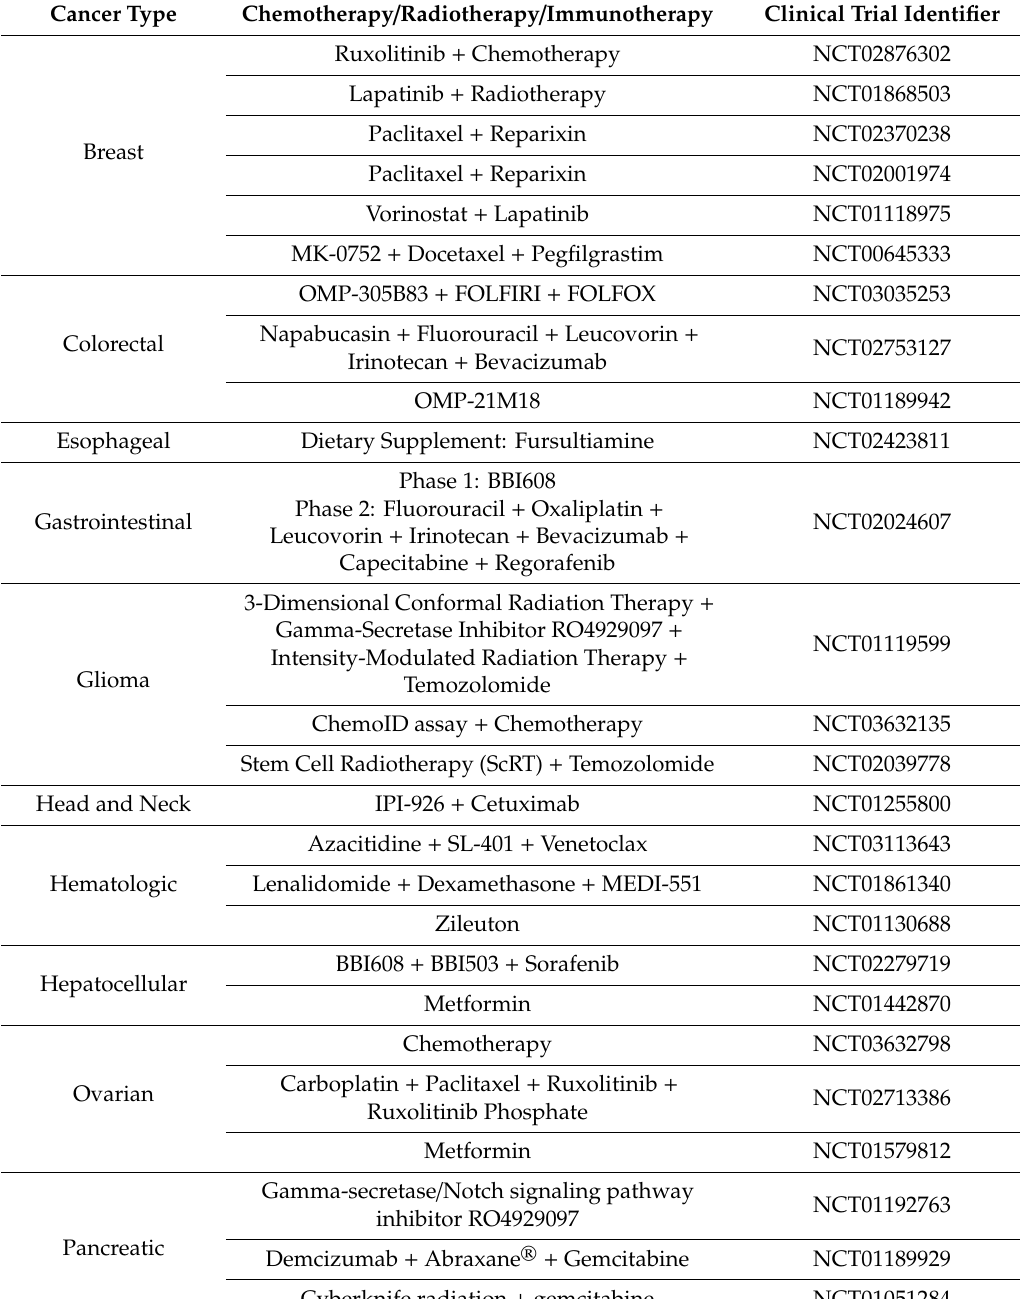
Table 2. Drugs currently under trial in combination with chemotherapy and radiotherapy for the treatment of di ff erent